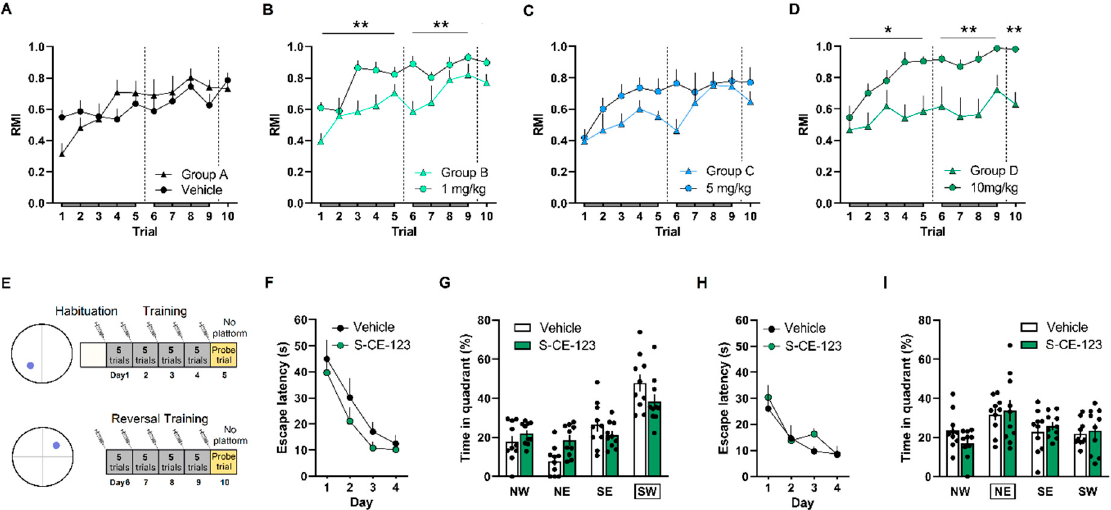
Figure 4. Analyses of hole-board RMIs in the first test (no treatment) compared to the second test (treatment) for ( A ) vehicle group (day1 (F 1,9 = 0.1125, p = 0.7450, 2-way RM-ANOVA); day2 (F 1,9 = 1.075, p = 0.3270, 2-way RM-ANOVA); day3 ( p = 0.3925, paired t -test)) and for S-CE-123 groups at